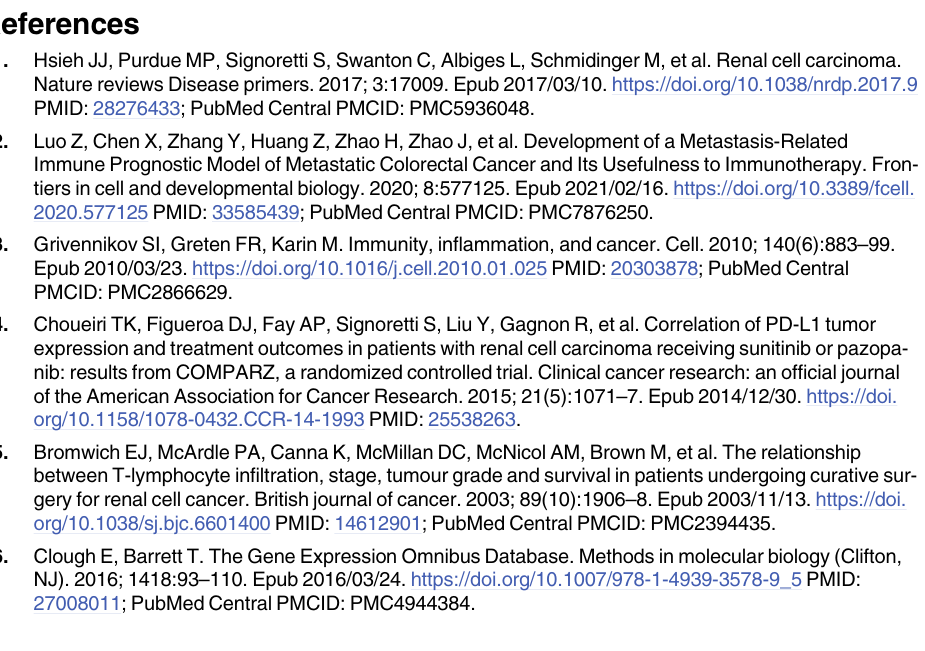
S1 Table. Primer sequences. S1 Fig. High- and low-risk grouping and clinical traits. (A–D) Boxplot representing risk scores for different clinical traits. S2 Fig. High- and low-risk assessment grouping and genetics changes. (A-B) Waterfall plot of tumor mutation load in the two risk subgroups. (C) Differential analysis of tumor mutation load in the two risk